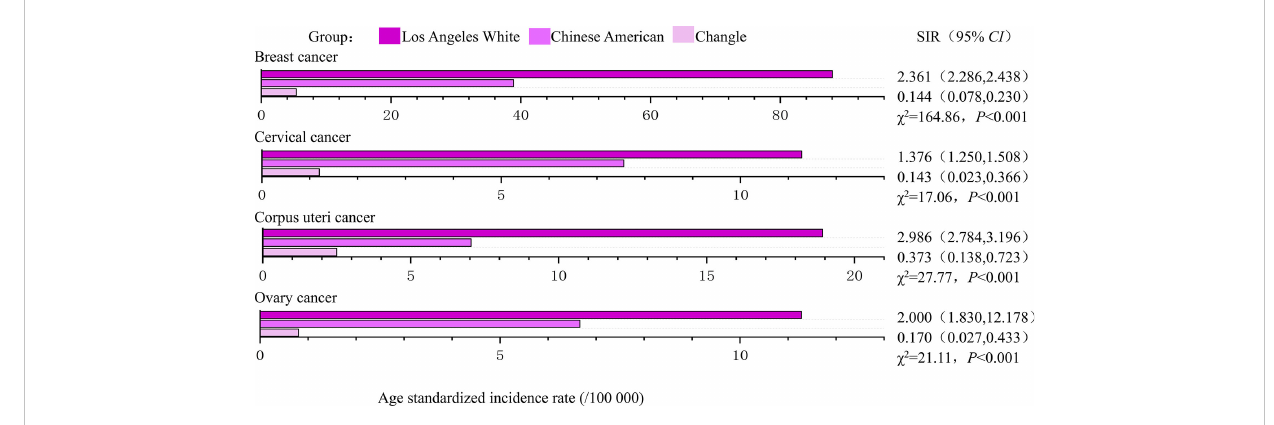
FIGURE 2 The age-standardized incidences and disparities in women ’ s cancer in 1988-1992. SIR, standardized incidence